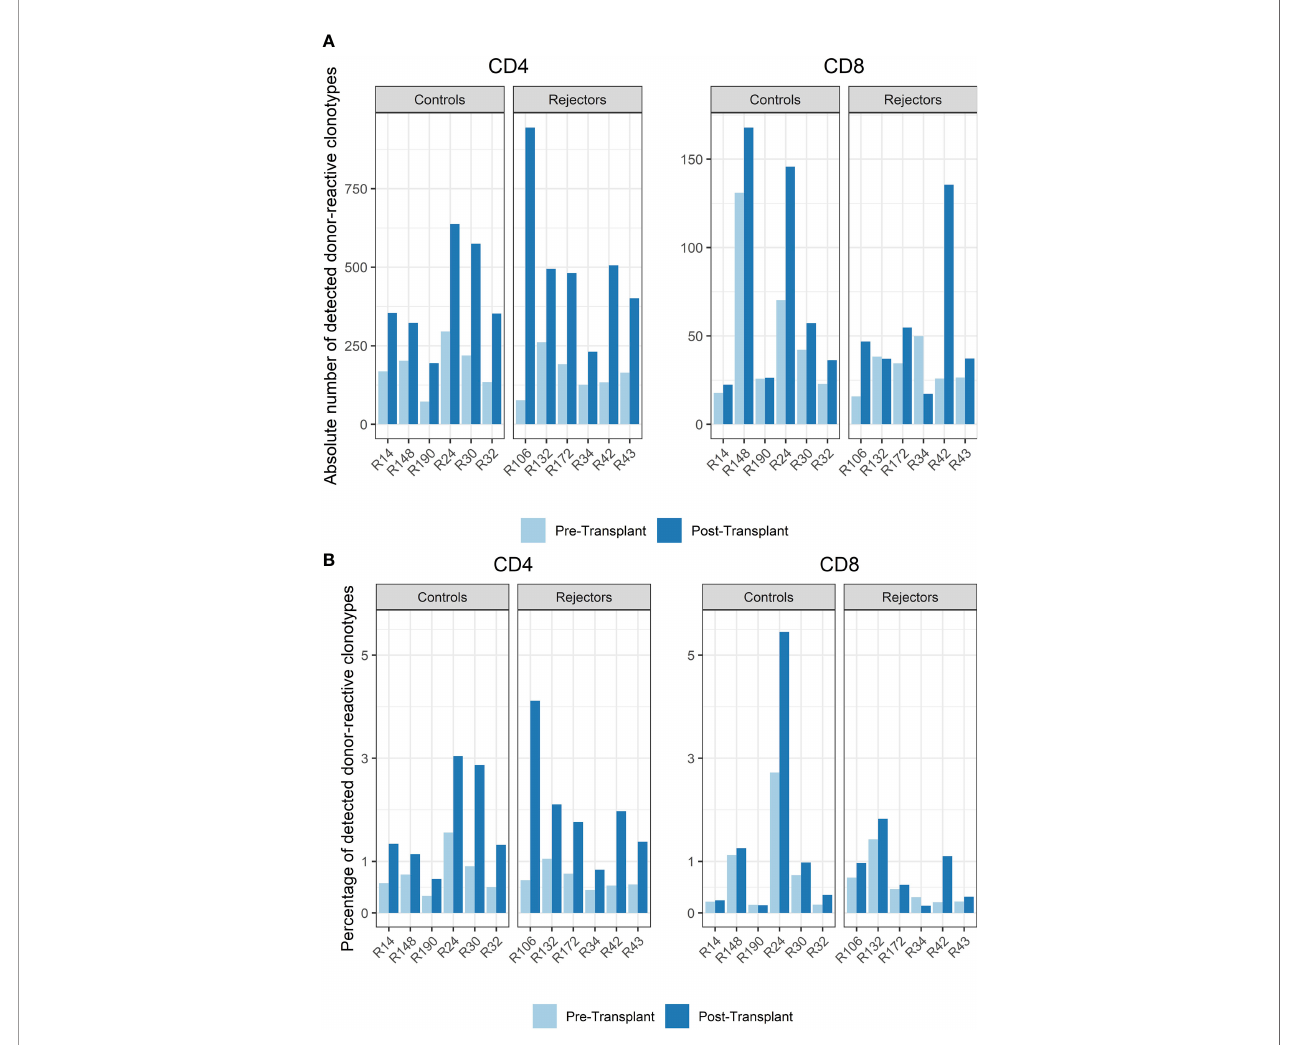
FIGURE 3 | (A) Absolute number of detected donor-reactive clonotypes after normalization by downsampling to the smallest number of reads. (B) Percentage of detected donor-reactive clonotypes after normalization by downsampling to the smallest number of reads. A signi fi cant increase in the percentage of donor-reactive CD4-positive clonotypes (p < 0.001, mean dif.: -1.168, CI: -1.724, -0.612) and their absolute numbers (p < 0.001, mean dif.: -1.197, CI: -1.802, -0.593) was seen in patients with anti-CD-25 induction therapy after transplantation compared to pre-transplant assessed by paired and unpaired Student ’ s